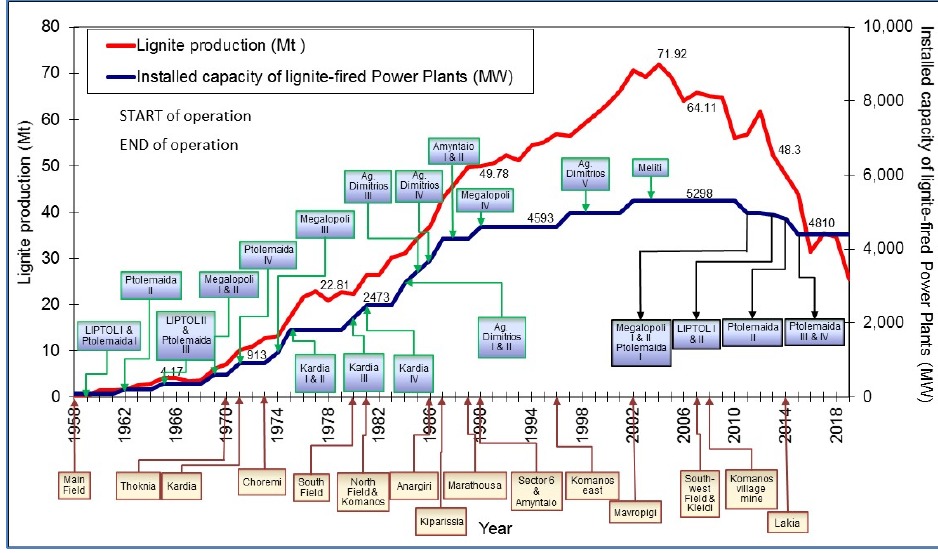
Figure 1. Lignite production (Mt) of PPC mines and the installed capacity of lignite-fired power plants (MW) (1959–2019).